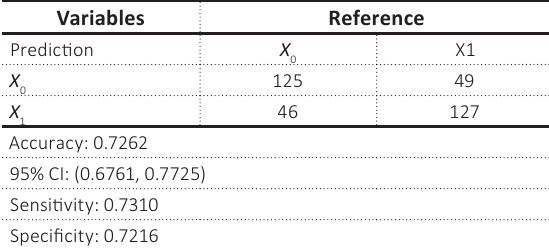
Table 7. Confusion matrix and statistics